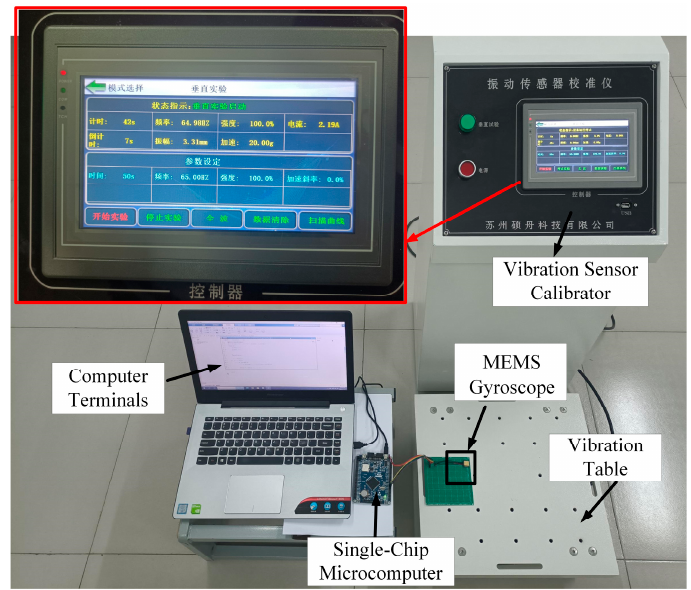
Figure 3. Vibration test device diagram.